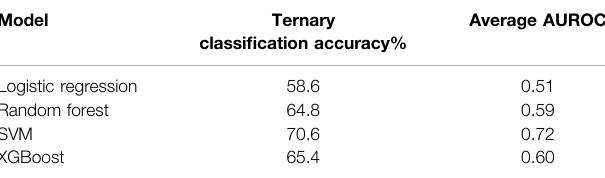
TABLE 1 | Comparison between the performance of traditional classi fi ers. Model Ternary classi fi cation